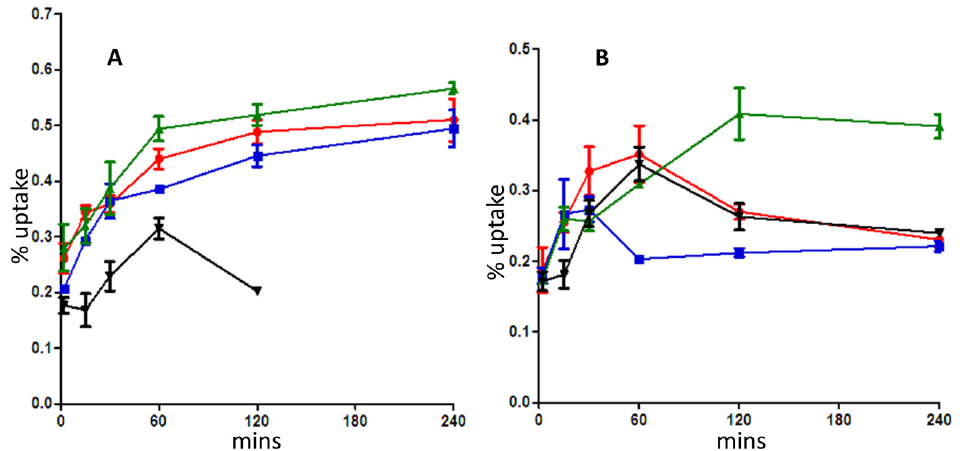
Figure 3. Results for cell lines MDA( ), A375( ), PC3( ) and MCF7( ).Uptake profiles for compound 67 Ga-[ 4 ] ( A ) and compound 67 Ga-[ 8 ] ( B ). The data is expressed as a percentage uptake of the total initial activity. Competitive inhibition of uptake of compound 67 Ga-[ 4 ] ( C ) by L -glutamine ( a ), BCH ( b ), MeAIB ( c ) expressed as a percentage of the